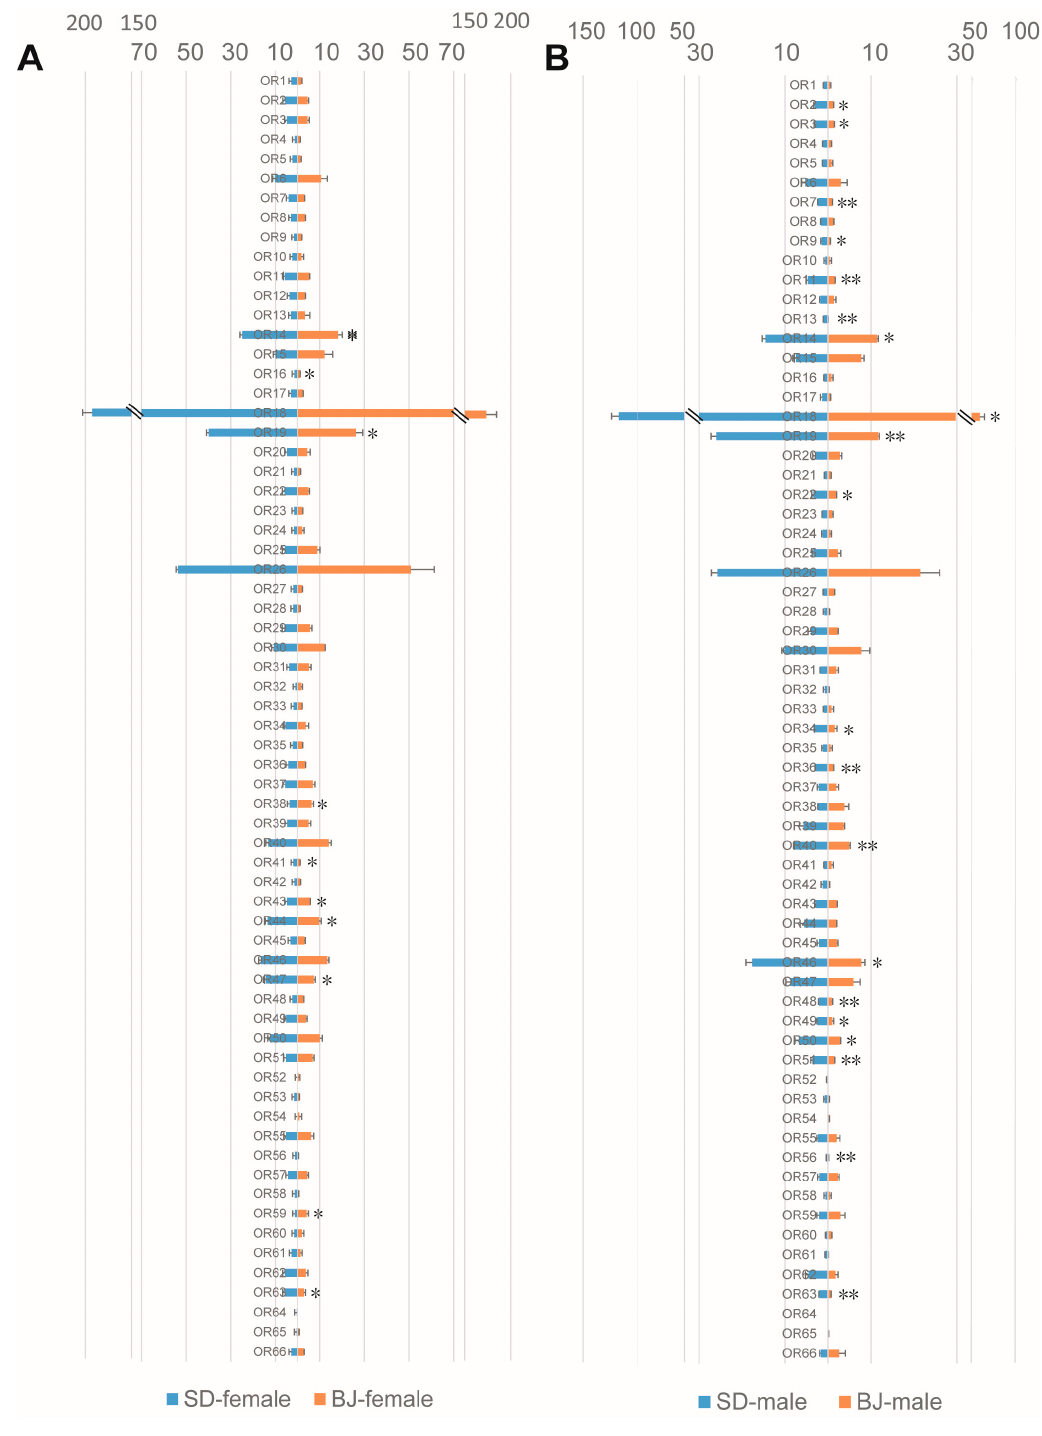
Figure 2. Comparison of odorant receptor (OR) genes expression levels in both sexes of the two S. bifasciatus populations. The horizontal axis refers to the expression level of the genes (FPKM values, mean ± SE, n = 3). ( A ): ORs expression level comparison between females of the two population; ( B ): ORs expression level comparison between males of the two population. BJ, Beijing population; SD, Shandong population. * means the difference is significant at the 0.05 level; ** means the difference is significant at the 0.01 level.